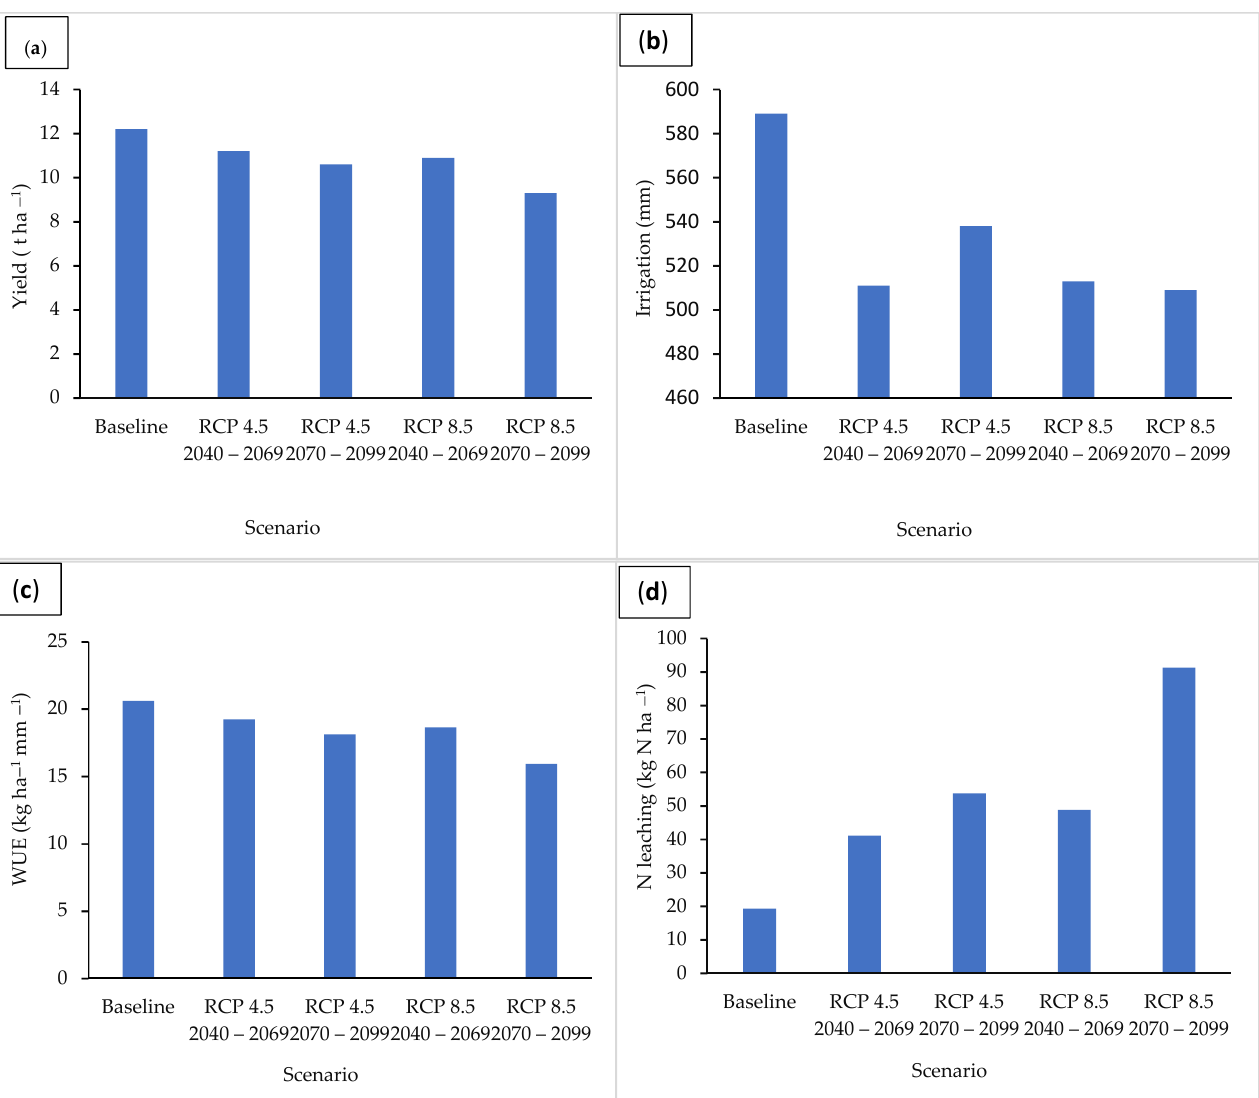
Figure 7. EPIC model outputs from the simulations using MIROC climate data. Values are plotted and shown for the two 30-year periods compared to the baseline simulation; ( a ) yield, ( b ) seasonal irrigation, ( c ) water use efficiency (WUE), ( d ) N leaching.